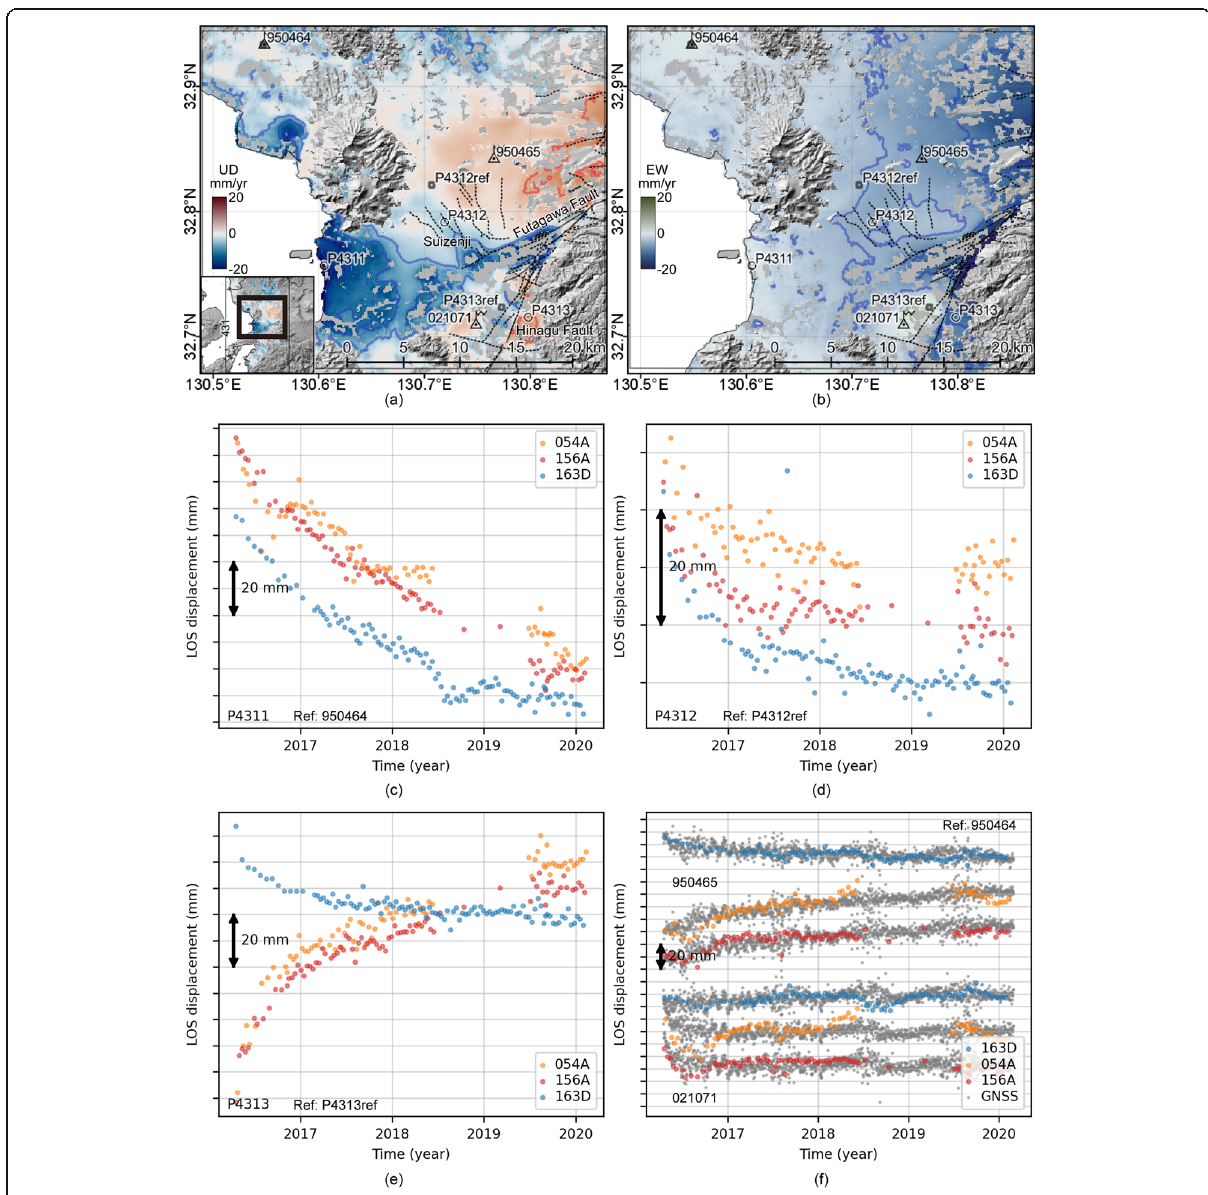
Fig. 15 a Vertical deformation velocities in a part of Kumamoto prefecture (ID: 431). The black dashed lines denote the small displacement lineaments identified by Fujiwara et al. (2016). The interval of the red (uplift) and blue (subsidence) contour lines is 5 mm/year without 0 mm/ year lines. The reference point is the 950464 GNSS station denoted by a triangle. The inset denotes the whole area of the 431 Kumamoto. b EW deformation velocities. c LOS deformation time series at P4311 (west coast) with reference to the 950464 GNSS station for each frame. d LOS deformation time series at P4312 (the Suizenji Park) with reference to P4312ref for each frame. e LOS deformation time series at P4313 (the Hinagu Fault) with reference to P4313ref for each frame. f LOS deformation time series at the 950465 and 021071 GNSS stations with reference to the 950464 for each frame and corresponding GNSS